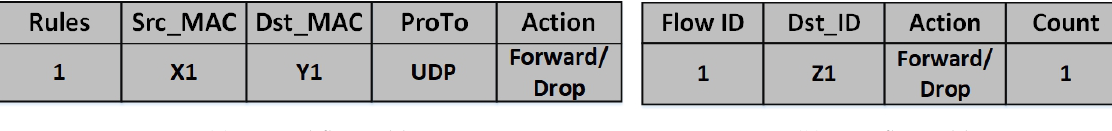
Figure 4. An example of a flow